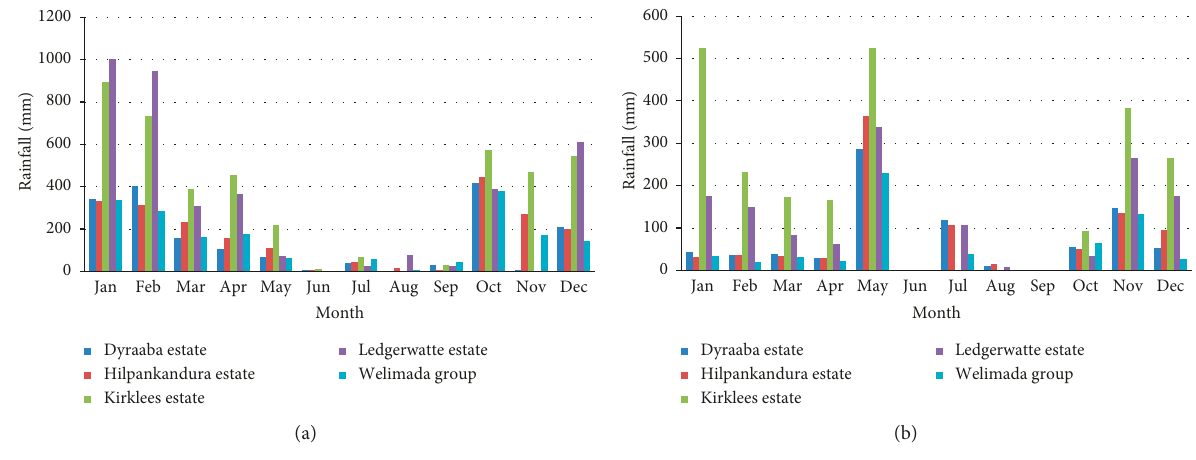
Figure 3: Monthly rainfall variation for years (a) 2011 and (b) 2016.